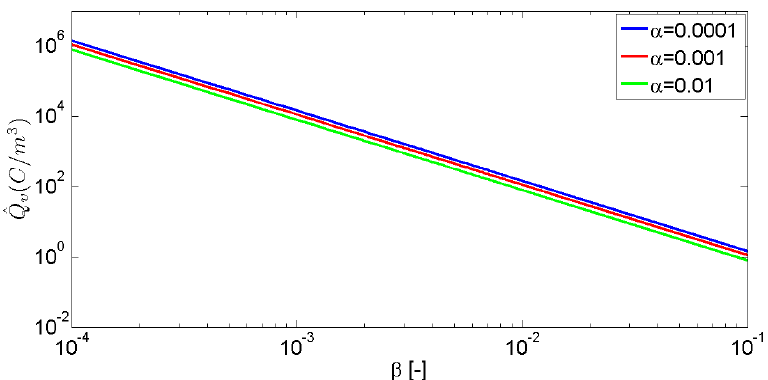
Figure 7. The variation of the (cid:98) Q v with the fracture aspect ratio β predicted from Equation (46) for three values of α (0.0001, 0.001 and